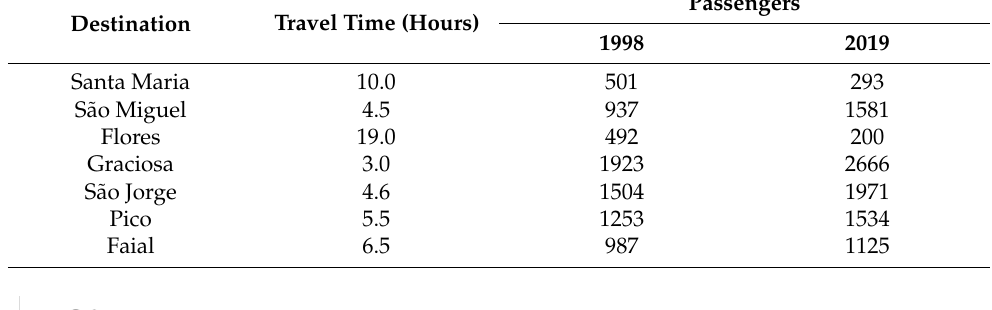
Table 6. Data for maritime connections to Terceira Island from the rest of the archipelago — for 1998 and 2019.